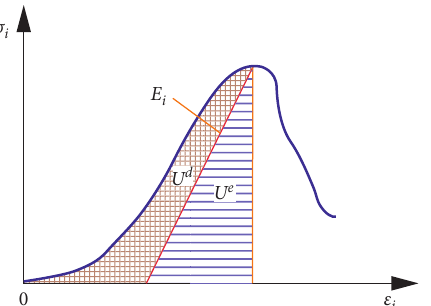
Figure 7: Strain energy relationship during the rock failure process